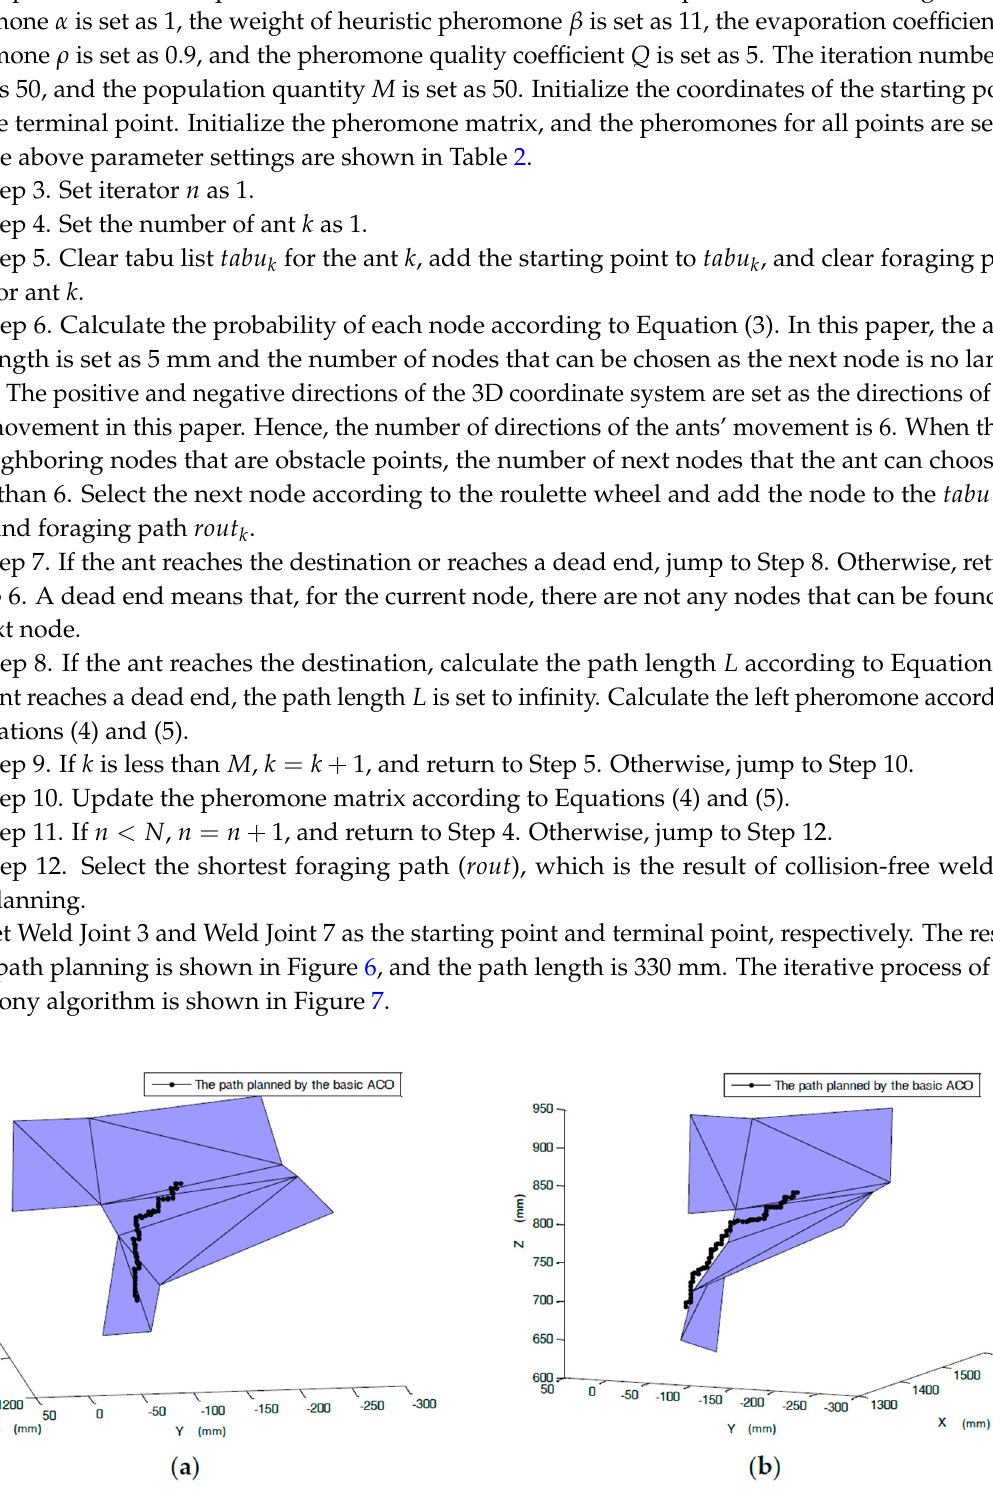
Figure 6. Welding robot path planning between two weld joints. ( a ) View A; ( b ) View B.